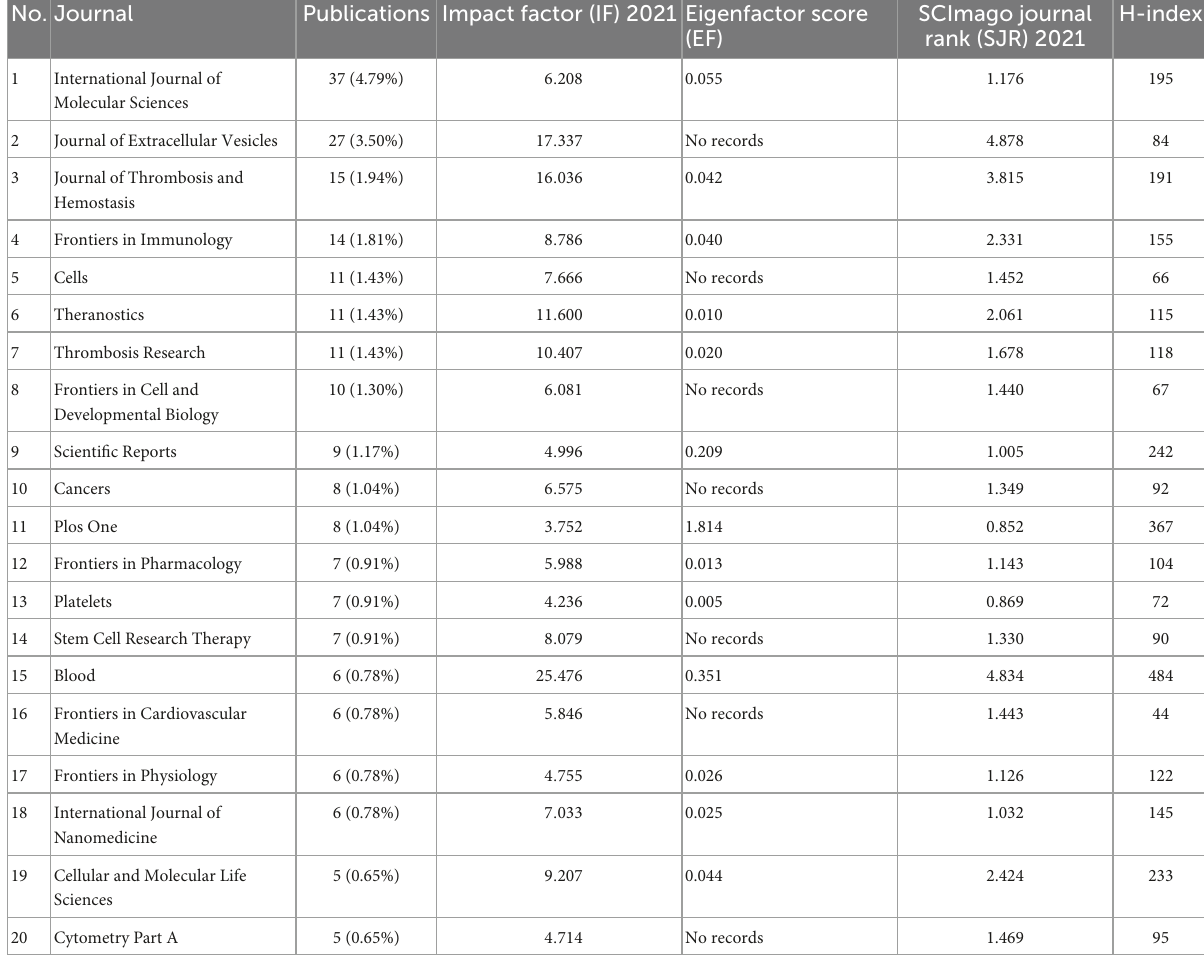
TABLE 4 Impact index of the top 20 journals with the largest number of